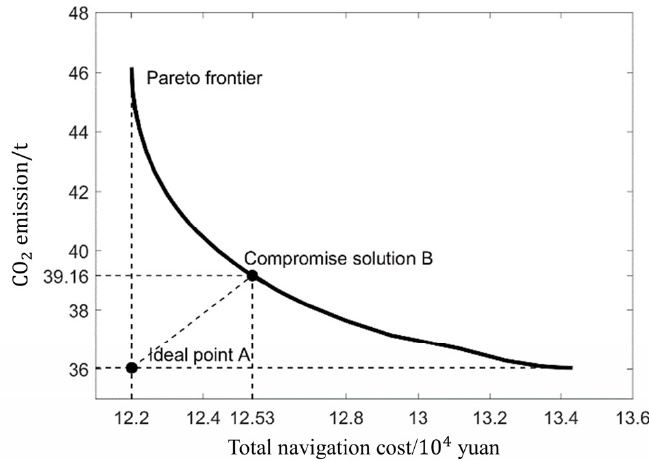
Figure 10. Selection of the compromised solution from the Pareto frontier.